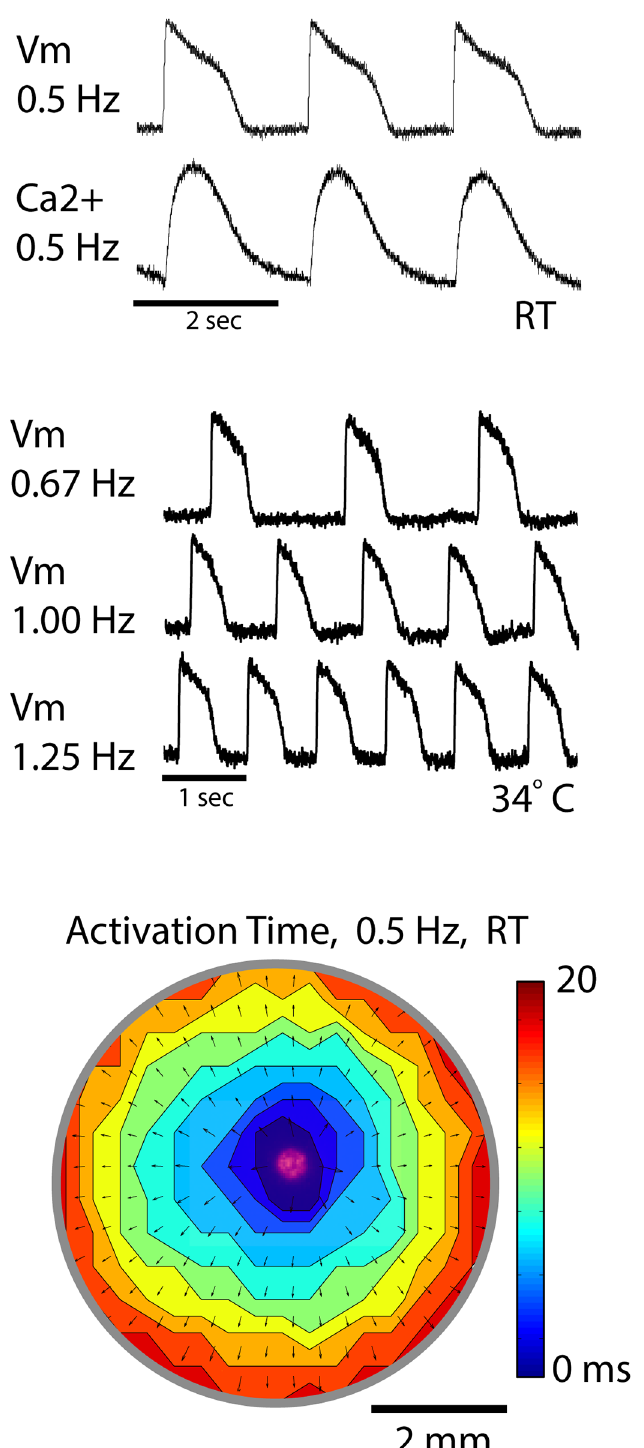
Fig 2. Demonstration of optical pacing and activation recording. Optical pacing in an hCM monolayer from a single well of a 96-wellplate. Top shows an action potentialrecording(Vm) and a Ca2+ transient recordingfrom a single pixel in separatewells at room temperature (RT). Middleshows action potentials recordedat 34˚C with faster pacingrates. Bottom shows an activationmap duringoptical pacingat 0.5 Hz indicating the local time of maximum Vm derivative(dVm/dt) duringthe action potentialupstroke. Vectors